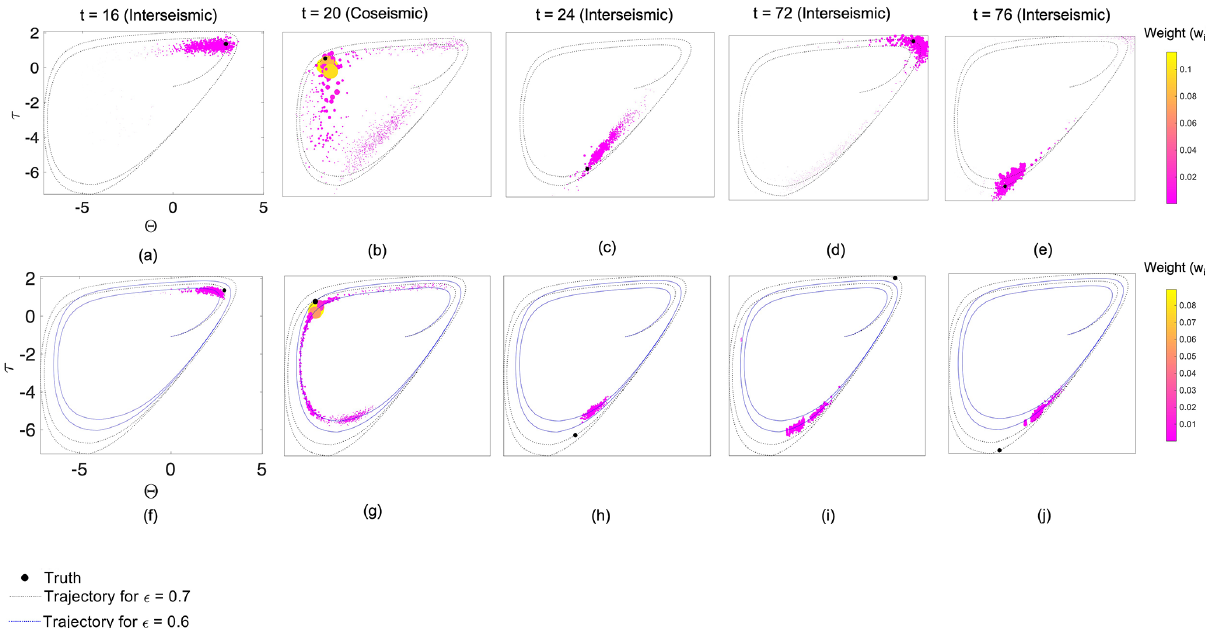
Figure 9. The (cid:50) – τ phase diagrams for the case with (a–e) state-parameter estimation and (f–j) state estimation for intermediate bias. The use of colors and lines is the same as in Fig.